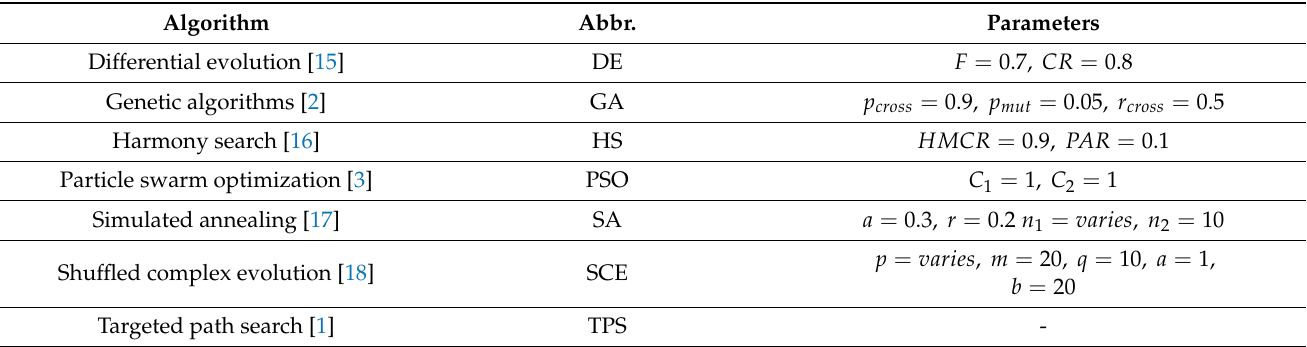
Table 3. Algorithms used in the applications alongside